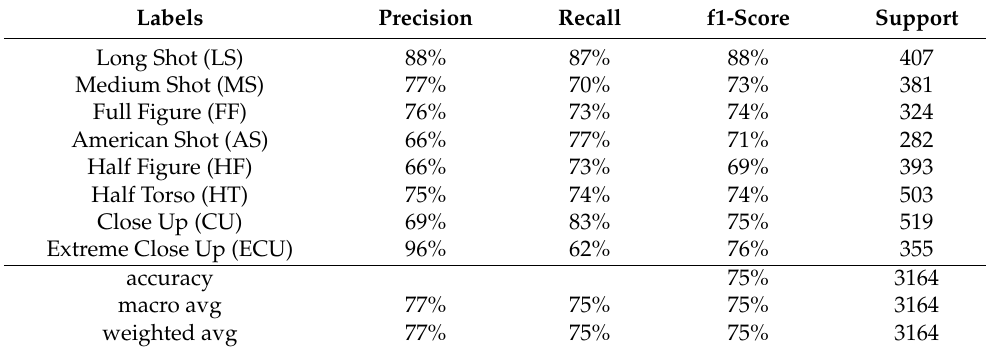
Table 13. Precision recall and f1-score of a VGG-16 trained on the augmented Original Dataset with the flip on the y-axis and zoom range = 0.3, i.e., Scenario 3.